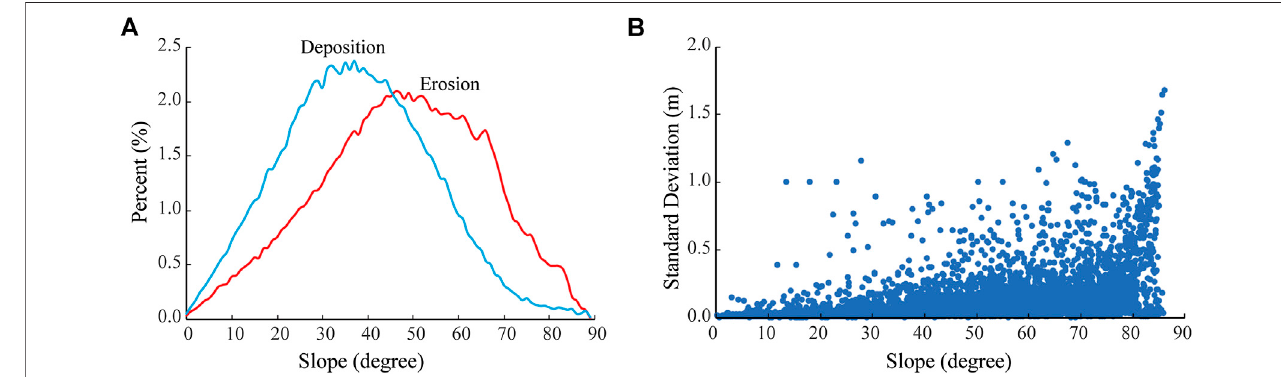
FIGURE7|(A) Thefrequencydistributionsoferosionanddepositionspotsondifferentslopes. (B) Therelationshipbetweentheuncertainty(standardderivation)of the DEM elevation and the slope.